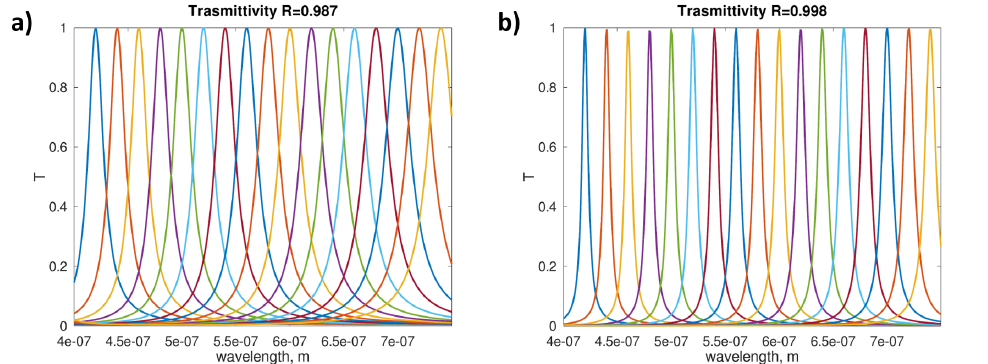
Figure 18. An ideal Fabry–Pérot interferometer (FPI) was considered; the first-order transmission maxima were obtained by scanning the distance d from 210 to 350 nm, with single steps equal to 10 nm. ( a ) The transmission profile of an ideal FPI composed by two infinite and identical extent plates ( R = 0.987), illuminated with a monochromatic plane wave at normal incidence; ( b ) the same simulation was performed with R = 0.998.